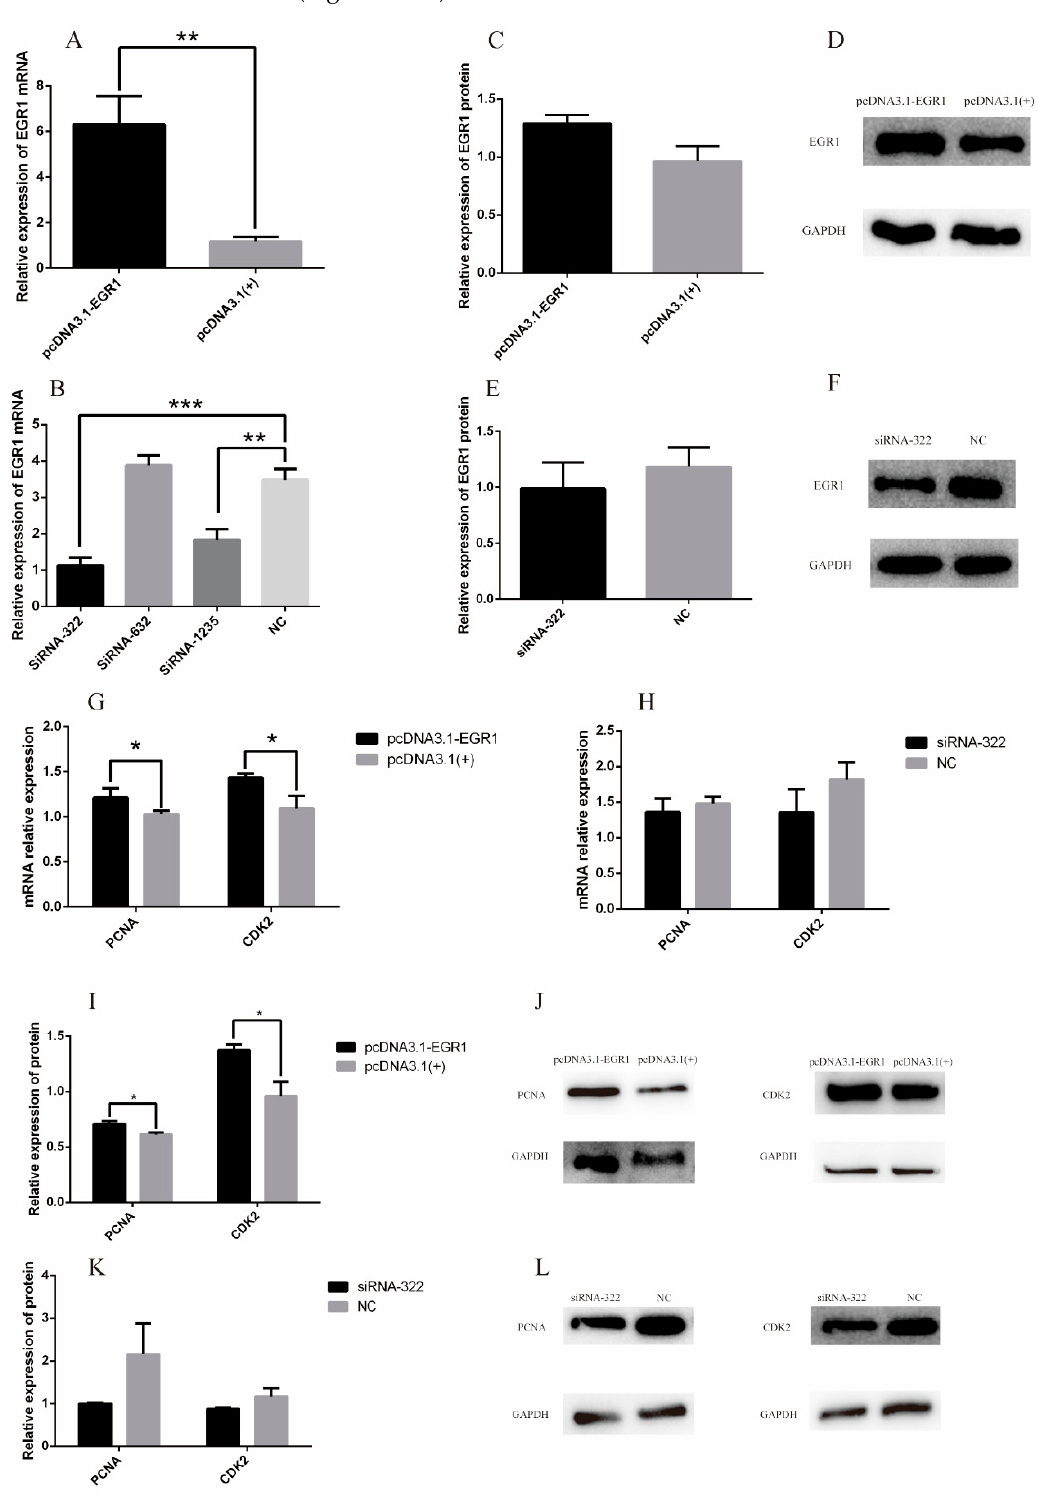
Figure 4. The effects of EGR1 on dermal papilla cell proliferation. ( A ) mRNA relative expression of EGR1 after pcDNA3.1-EGR1 transfection. ( B ) Relative expression of mRNA for EGR1 in DPCs transfected with siRNA. ( C ) Relative expression of EGR1 protein after pcDNA3.1-EGR1 transfection. ( D ) Protein bands after pcDNA3.1-EGR1 transfection. ( E ) Relative expression of protein for EGR1 gene in DPCs transfected with siRNA-322. ( F ) Protein bands for EGR1 in DPCs transfected with siRNA-